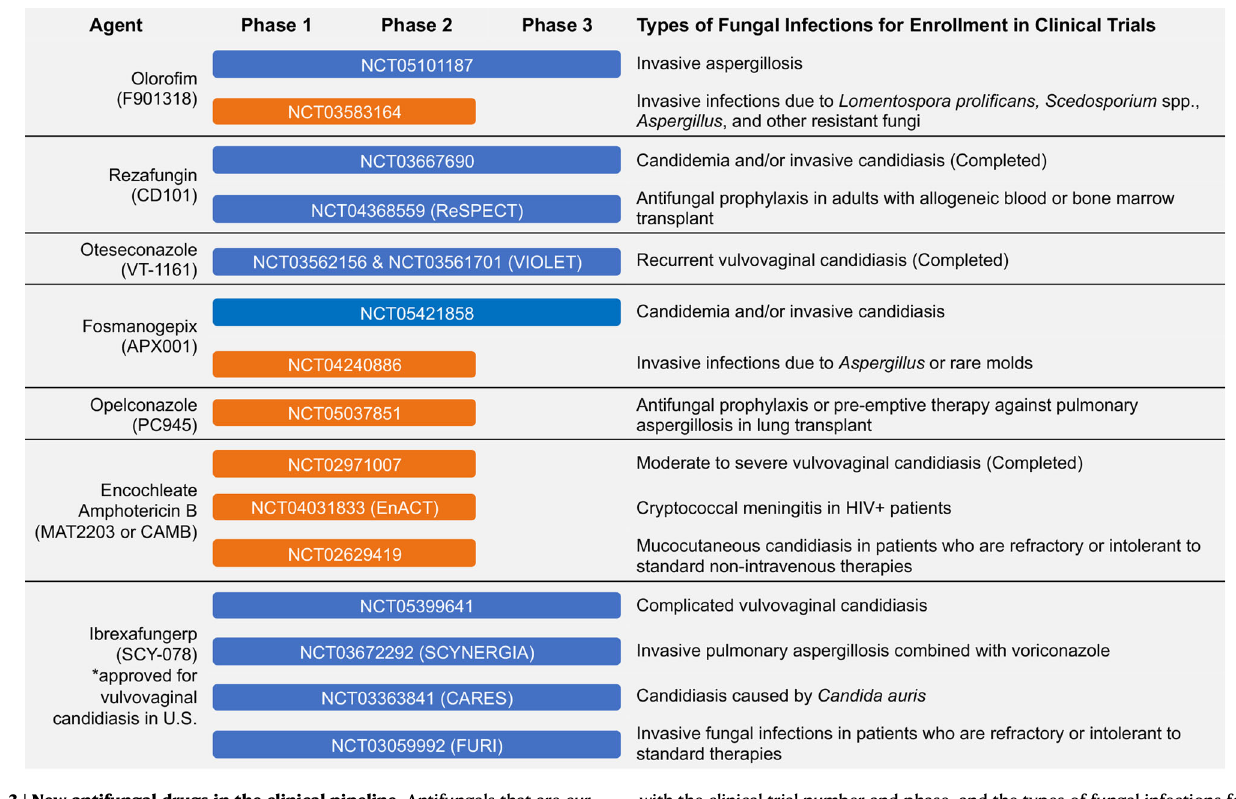
with the clinical trial number and phase, and the types of fungal infections for enrolment.InformationwasobtainedfromClinicalTrials.gov,adatabaseofpublicly and privately funded clinical studies (accessed June 27,